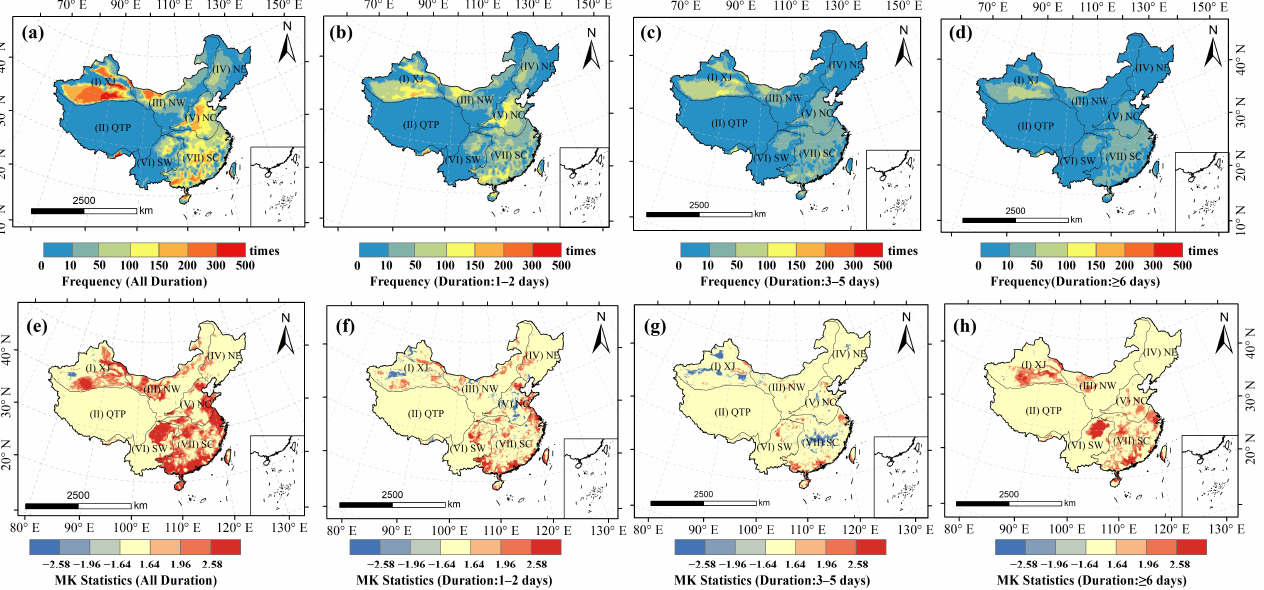
Figure 5. The spatial distribution of ( a – d ) accumulated frequency of heatwave events during the period of 1979–2018 and ( e – h ) associated Mann–Kendall (MK) analysis. period of 1979–2018 and ( e – h ) associated Mann–Kendall (MK)